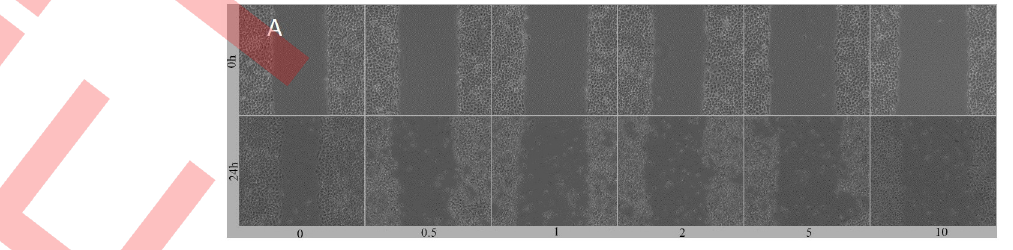
monitored after 24 h was 53.59 ± 0.11, 51.85 ± 0.01, and 17.7 ± 0.1 for HEK 293, HeLa, and SK-MEL-28, respectively, when 100 μ g/mL melanin was used. Maximum IC of 14.43 ± 0.02 with HeLa cells, 13.31 ± 0.01 with SK-MEL-28, and 64.11 ± 0.00 with HEK 293 (Fig 5). Anti-inflammatory activity. Melanin provided maximum protection (78.63 ± 0.01) and minimum hemolysis (21.37 ± 0.2%) when tested for in vitro anti-inflammatory activity at a dose of 500 μ g/mL. The results were correlated to that of standard drug, i.e., Diclofenac at similar concentrations protected in a range of (80.76 ± 0.01 and 19.24 ± 0.1%) the cells tested (Fig 6). Cell migration assay. Melanin had a significant effect on HeLa cell line migration pat- terns. Cell migration was significantly reduced at higher concentrations of melanin treatment, as observed in wound healing assay. The percentage of cells that invade the wounded areas was reduced in melanin (10 μ g/mL) treated HeLa with reduced cell proliferation (Fig 7).